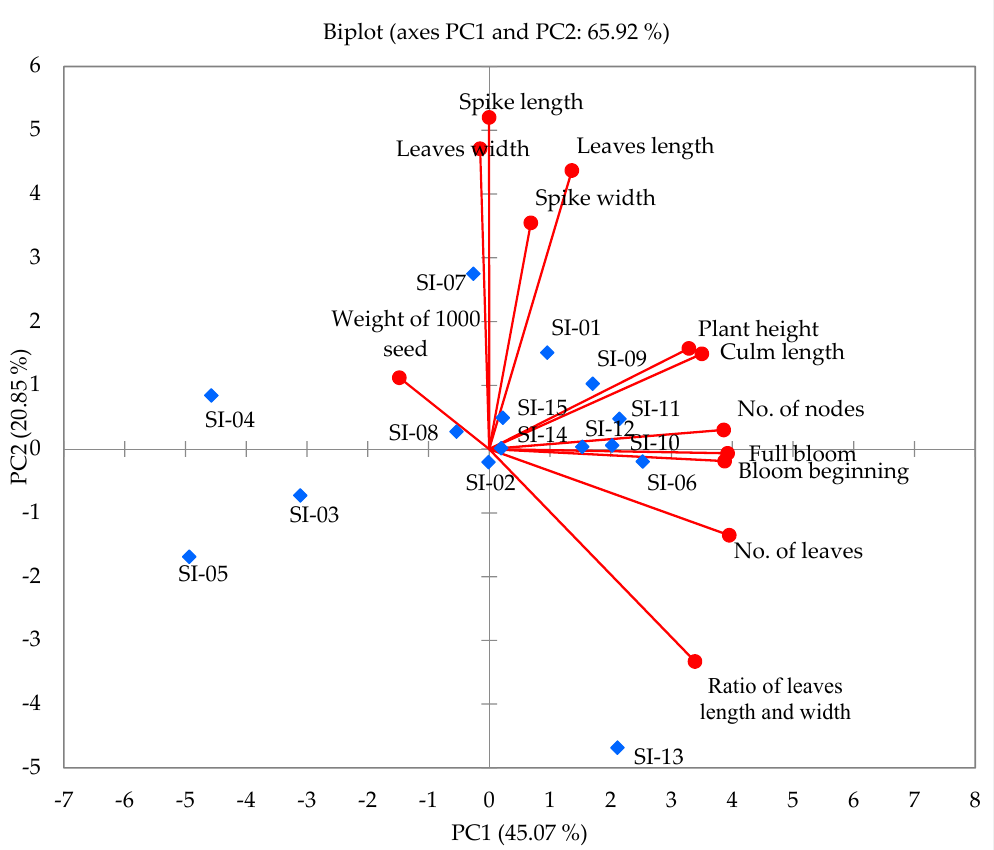
Figure 2. Two-dimensional plot of PC1 and PC2 principal components analysis in the 15 accessions in S. italica based on morphological characters.